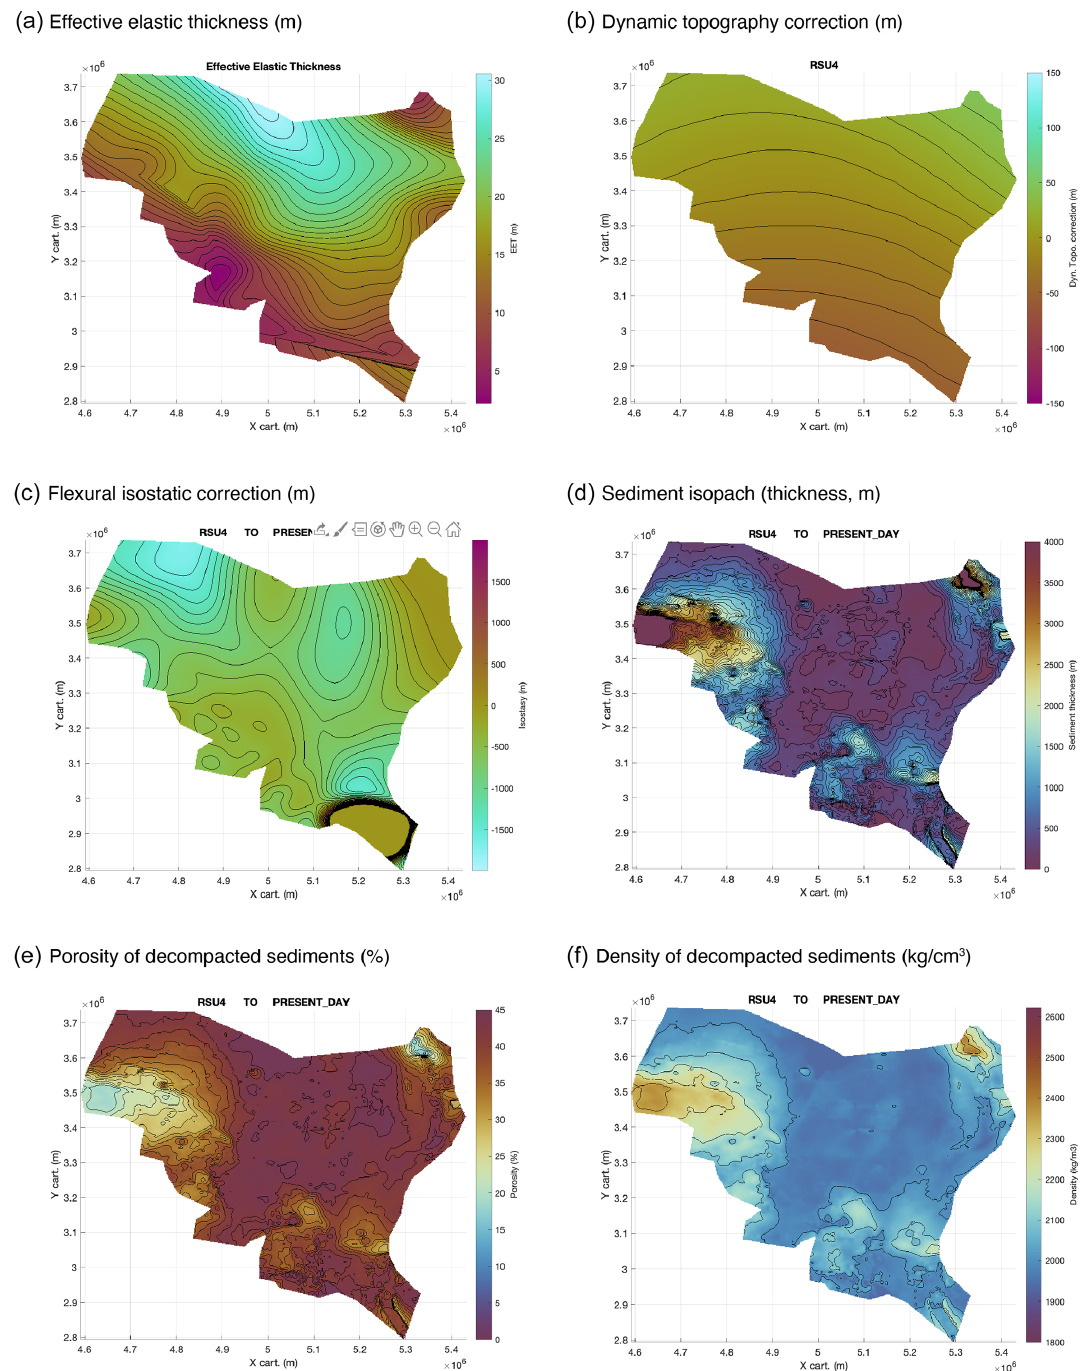
Figure A1. Example of input data and related backtracked sediment variables during the mid-Miocene: (a) spatially variable lithospheric elastic thickness (Chen et al., 2018) and (b) dynamic topography correction (Müller et al., 2018b). Both (a) and (b) are user-provided input to PALEOSTRIP. (c) Flexural isostatic correction calculated using (a) . (d) Decompacted isopach ( m ) . (e) Decompacted porosity ( % ) . (f) Decompacted density (kgcm − 3 ). Note that the colour scale is colour-blind friendly and is from Crameri et al. (2020). PALEOSTRIP has implemented 12 different colour scales, and 9 out of 12 are colour-blind